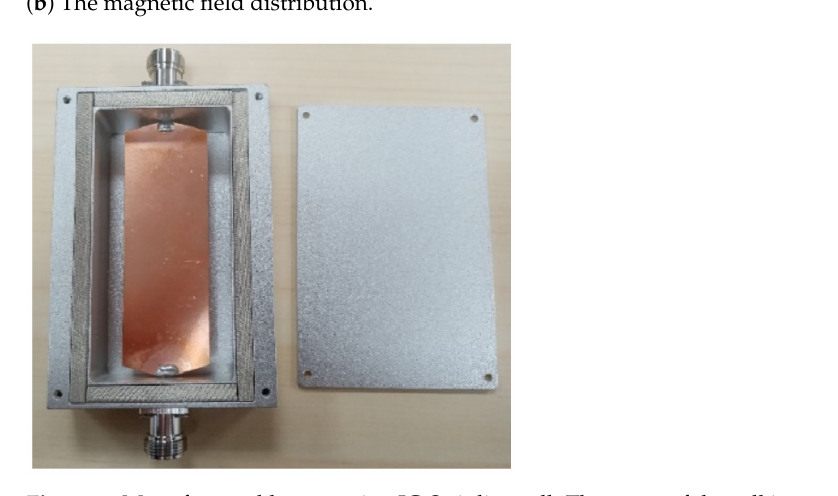
Figure 8. Manufactured long version IC-Stripline cell. The cover of the cell is